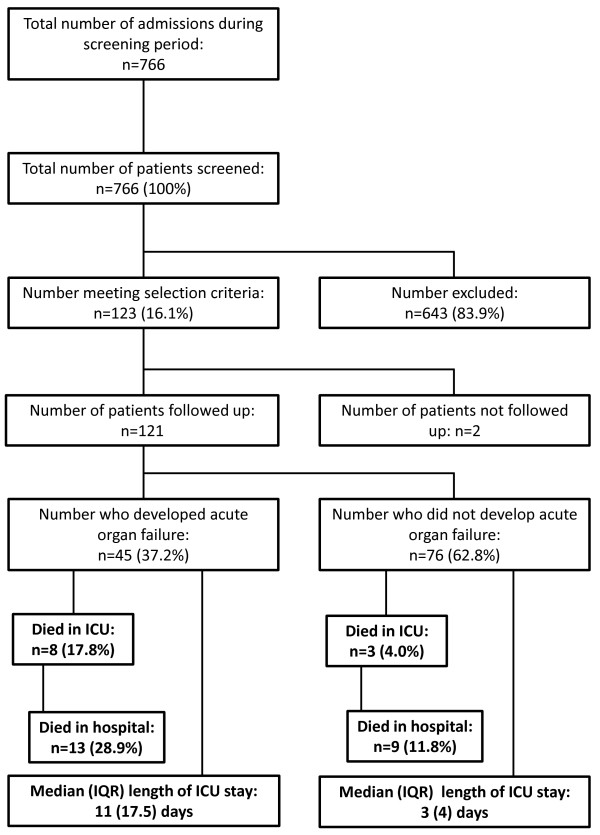
Flow diagram of study patients and outcomes.